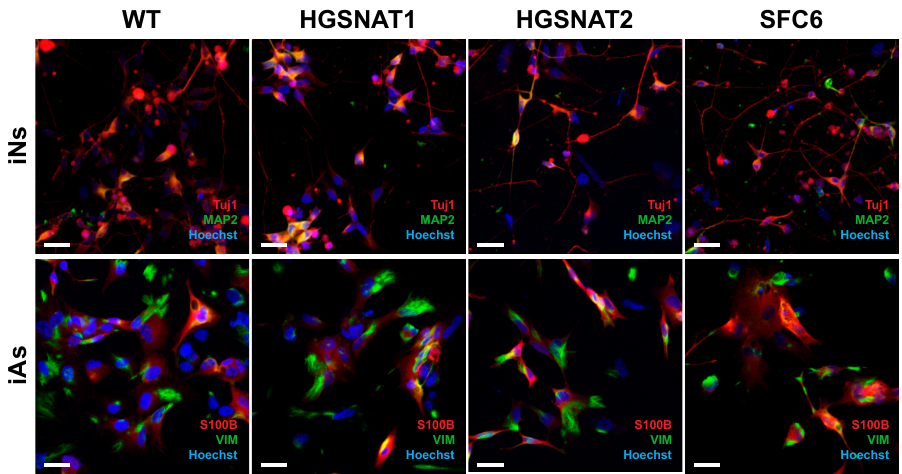
Figure 3. Representative images of differentiated iNs from all iPSC lines (WT, HGSNAT1, HGSNAT2, and SFC6) positive for Tuj1 (red) and MAP2 (green) and iAs from all iPSC lines positive for S100B (red) and VIM (green). Nuclei were detected with Hoechst (blue). Scale bar = 25 µm.